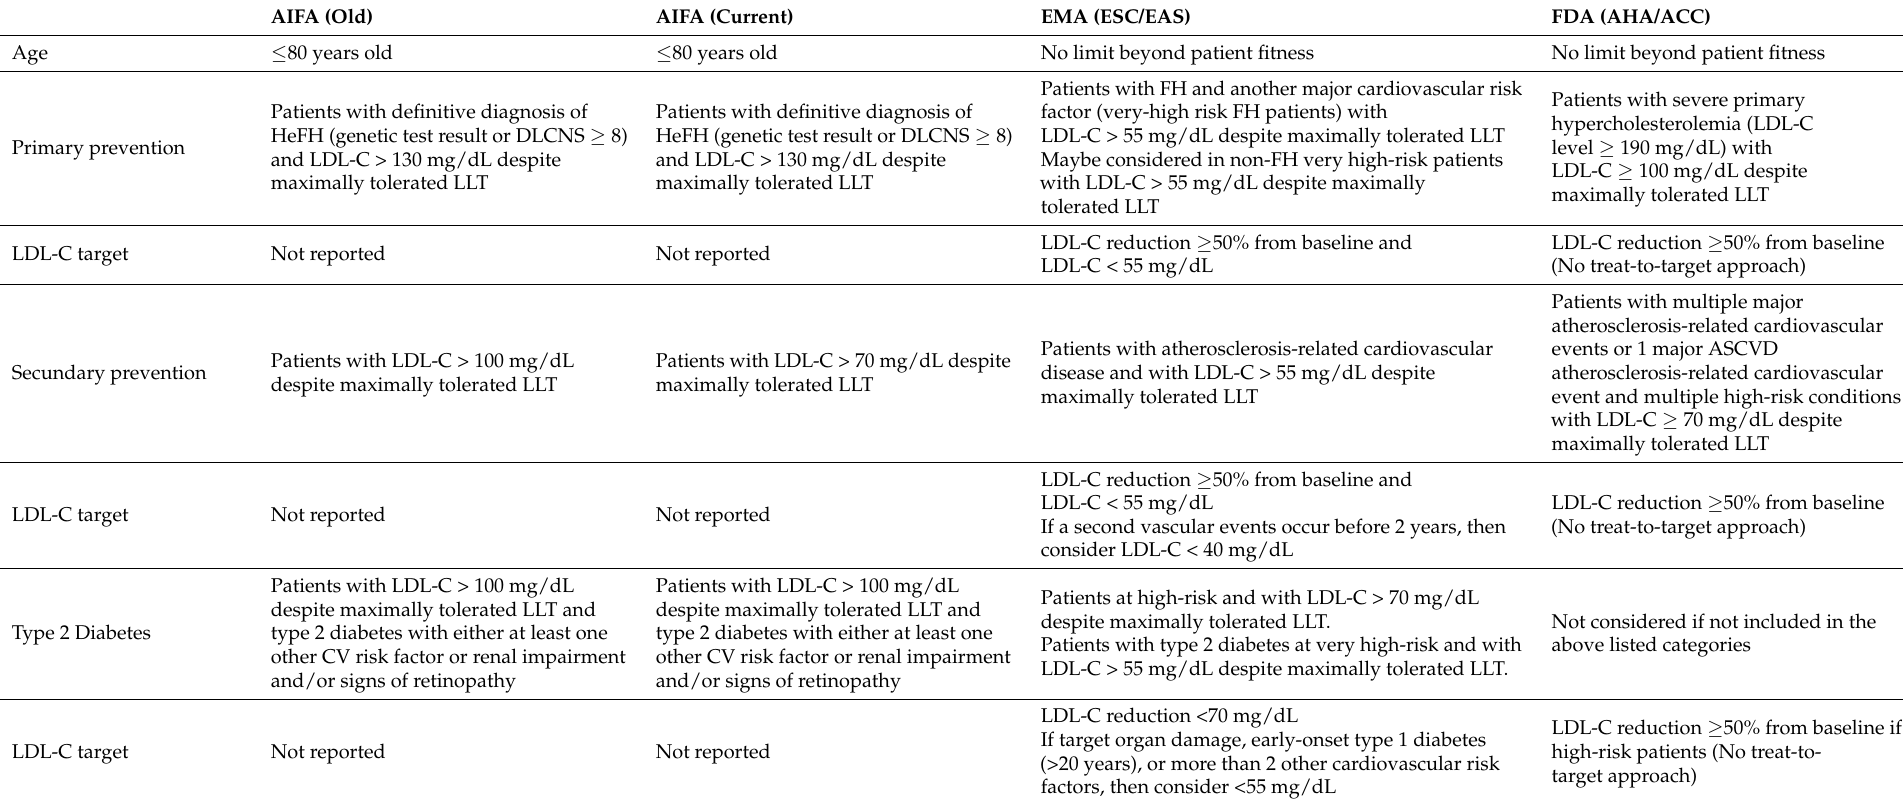
Table 1. AIFA reimbursement rules and EMA and FDA prescription criteria for the PCSK9